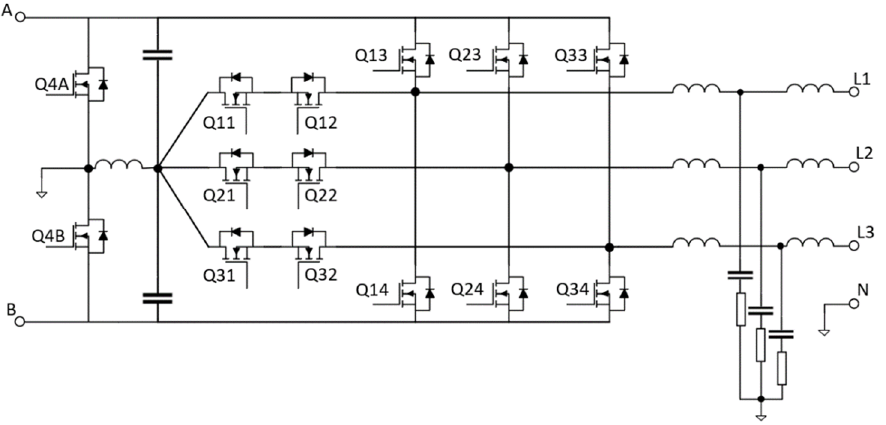
Figure 3. A three-level, three-phase, four-wire inverter with a split DC link and an active balancer. Figure 3. A three‑level, three‑phase, four‑wire inverter with a split DC link and an active balancer. If inverter efficiency is omitted, then this equation can be used to approximate